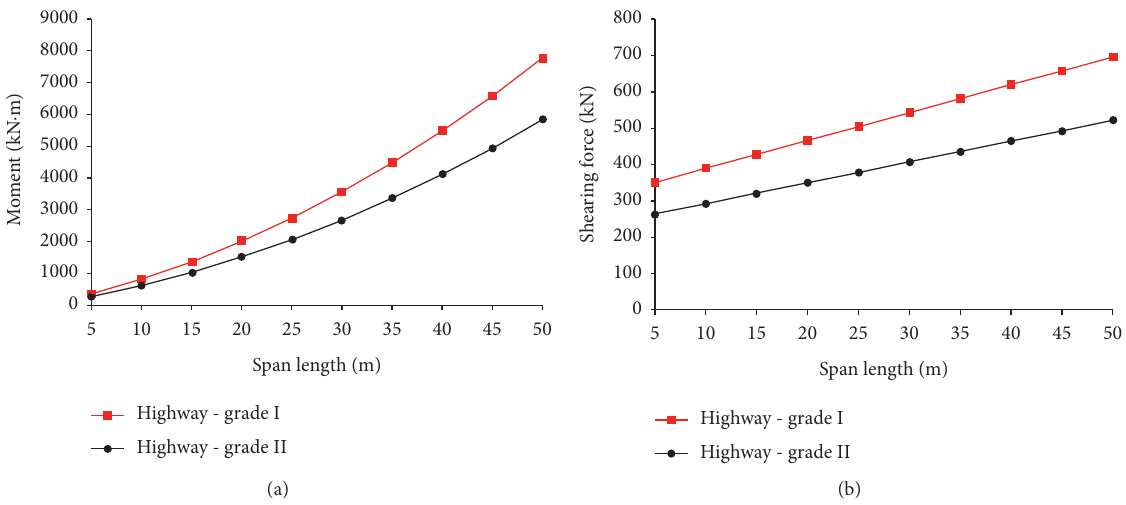
Figure 5: Traffic loading effects in JTG D60-2015: (a) moment and (b) shearing